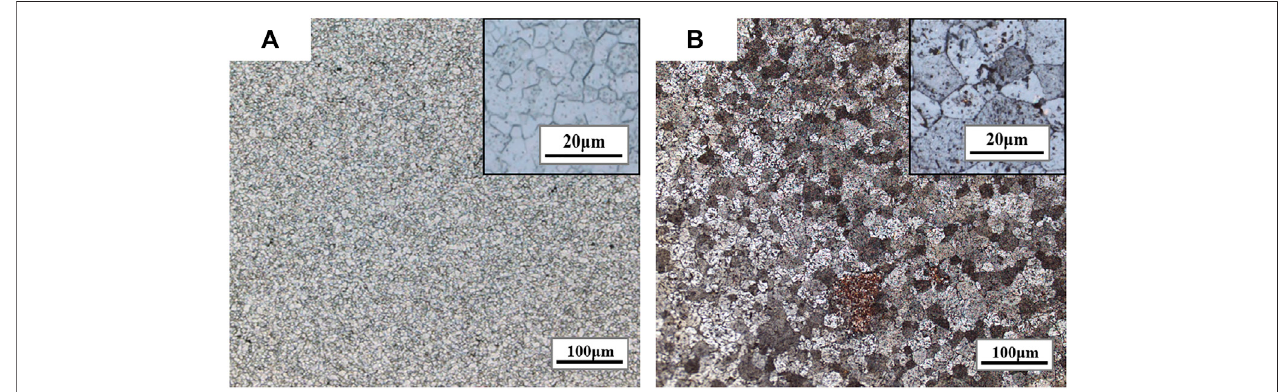
FIGURE 6 | Grain morphologies of pure UO 2 sintered under different sintering atmospheres. (A) H 2 ; (B) H 2 -CO 2 .